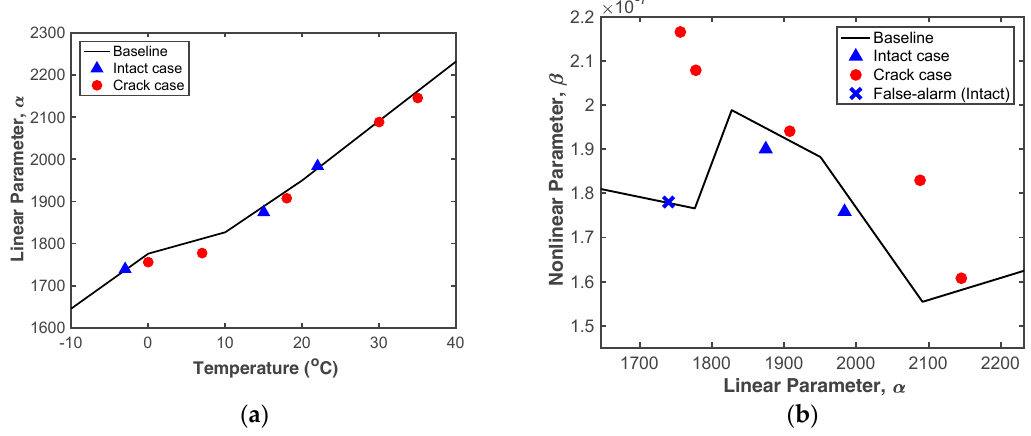
Figure 12. Experimental results: ( a ) Temperature vs. α , ( b ) α vs. β .